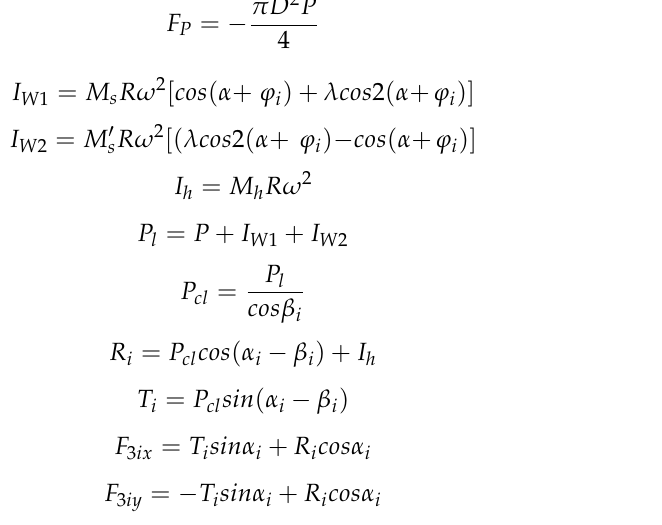
placement of the plunger is S(α) [1 4].